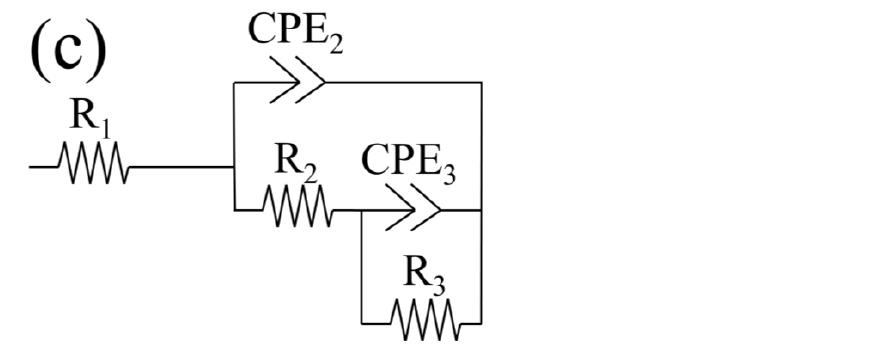
Figure 5. Equivalent circuits of the corrosion mechanisms of the ( a , b ) non-textured commercial pure aluminium at ( a ) 2 h and 24 h immersion and, ( b ) 48 h, 72 h and 96 h immersion and, ( c ) textured commercial pure aluminium at all immersion times in 0.6 M NaCl.